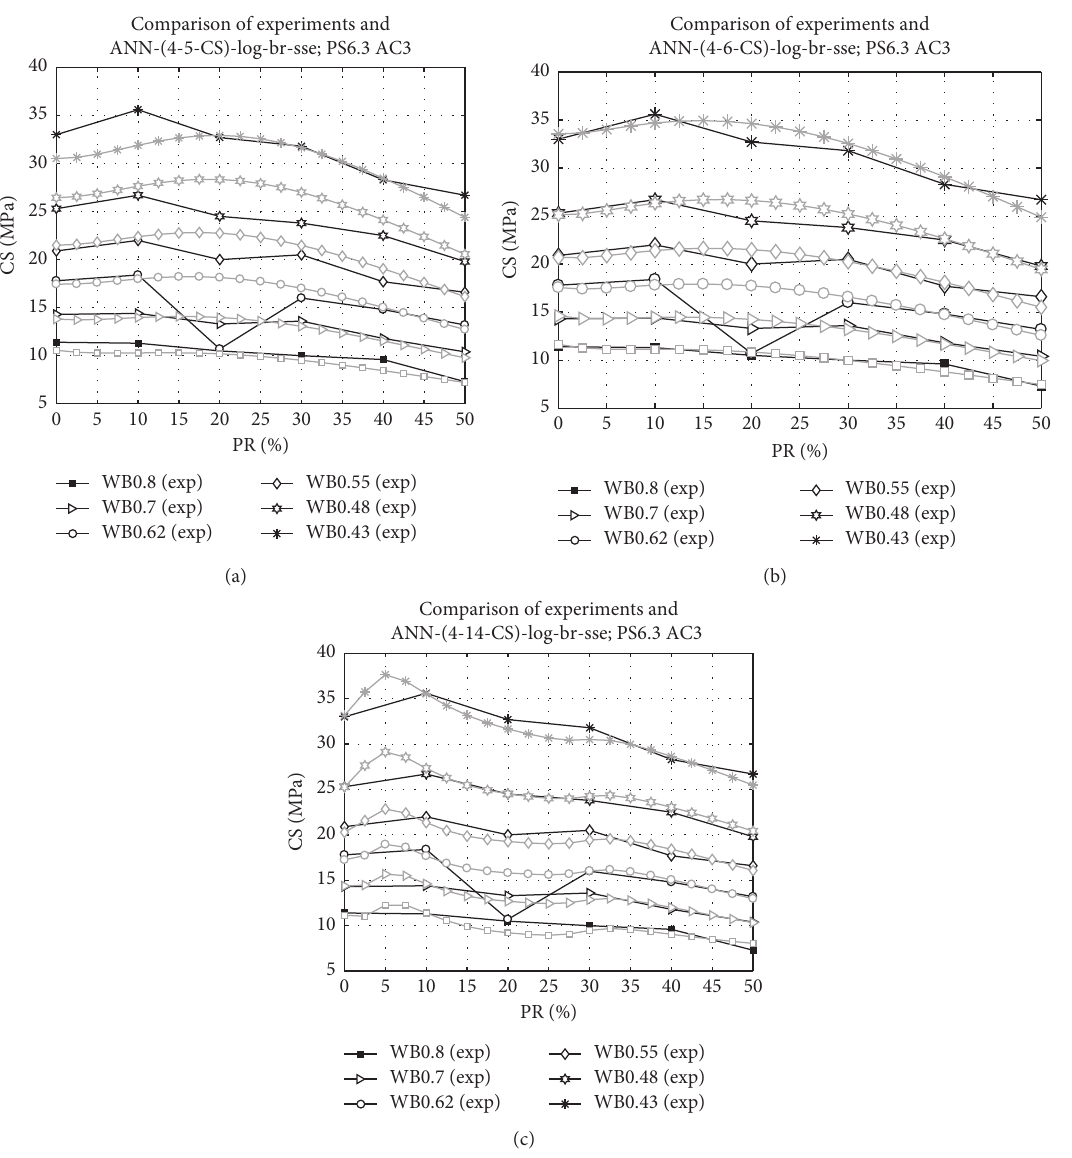
Figure 2: Comparison between the 2D plots of experimental results and predictive results of the ANN model architectures with one hidden layer. (a) One hidden layer with 5 neurons. (b) One hidden layer with 6 neurons. (c) One hidden layer with 14